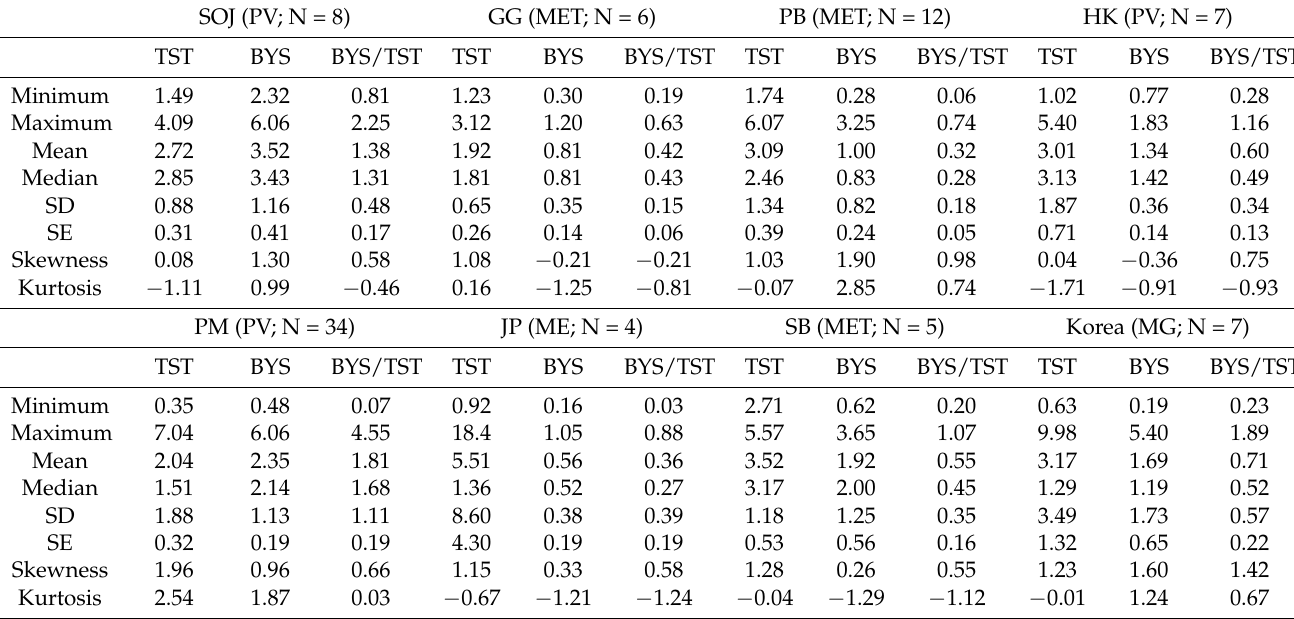
Table 1. Overall statistics of concentrations (mg/kg dry weight) of Cd in the byssus (BYS) and total soft tissues (TST) of Perna viridis and their ratios (BYS/TST), collected from 34 populations in the coastal waters of Peninsular Malaysia (PM) and 2 sites in the Straits of Johore (SOJ) during experiment from the present study, along with those reported in the